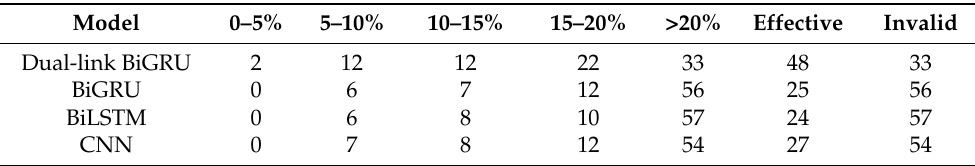
Table 3. Comparison of model